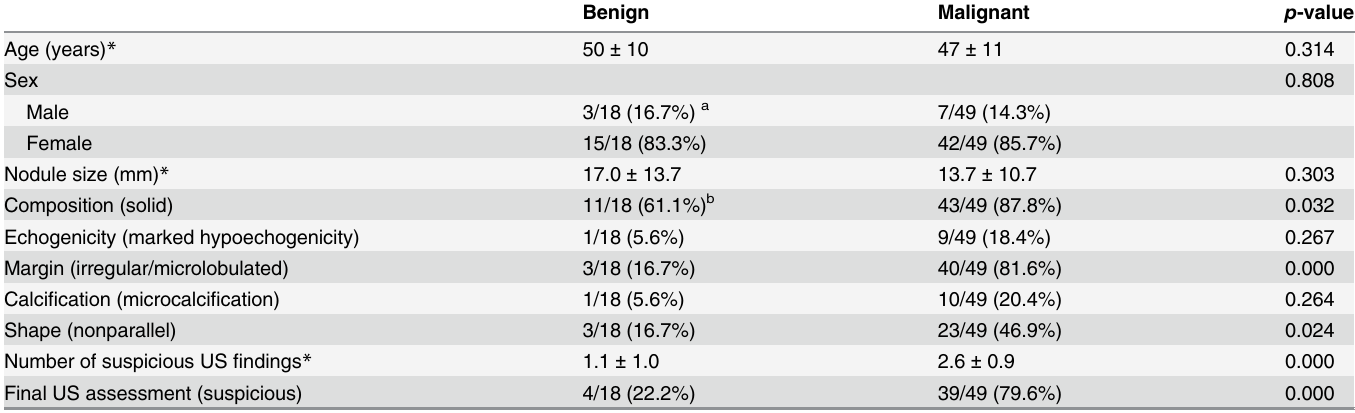
Table 3. Clinical and Ultrasonographic Characteristics of Repeat Bethesda Category III